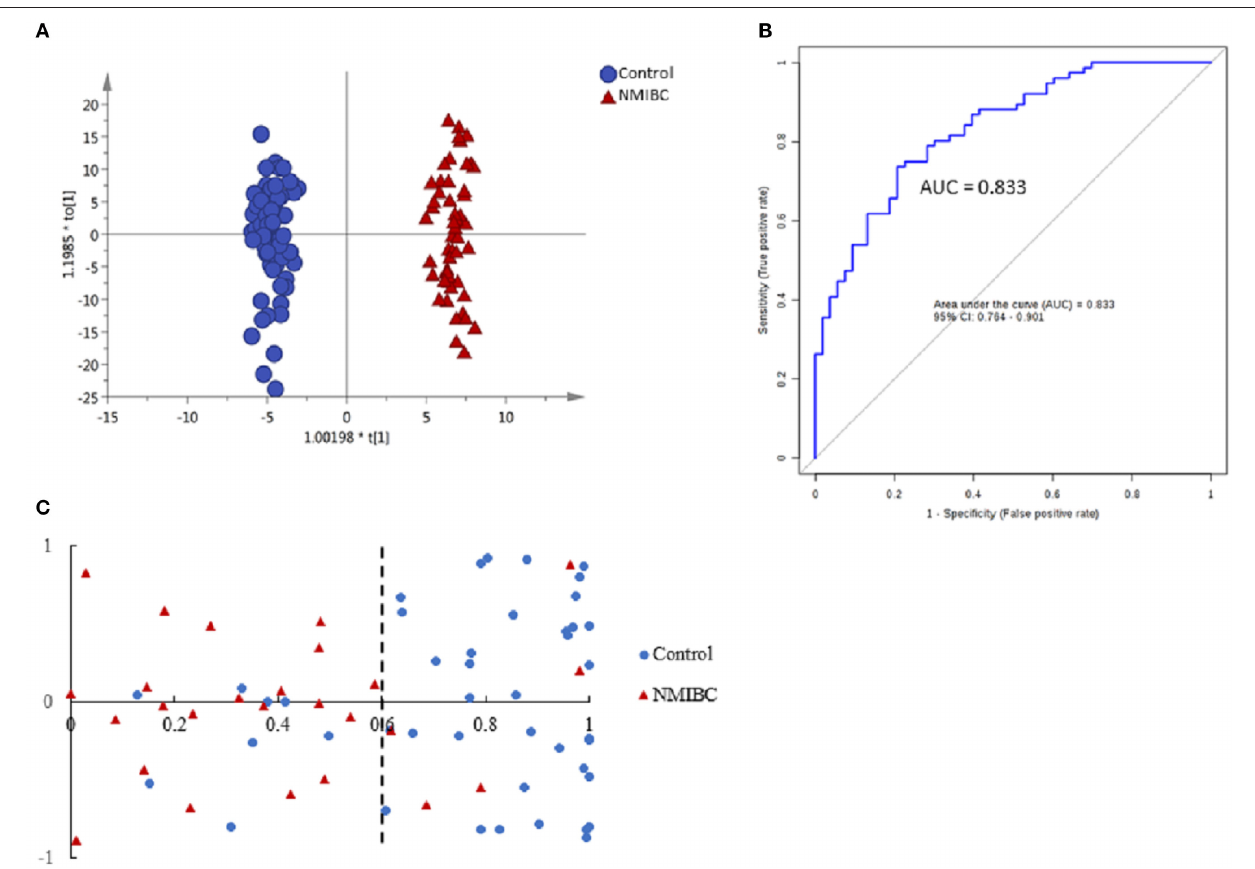
FIGURE 2 | Analysis of metabolic profiling in NMIBC as compared with control group. (A) Score plot of OPLS-DA model based on metabolome between NMIBC and control group. (B) ROC plot based on model to quantify the discrimination degree of NMIBC and control group. (C) External prediction accuracy of NMIBC prediction model established by a metabolite panel of Dopamine 4-sulfate, MG00/1846Z,9Z,12Z,15Z/00, Aspartyl-Histidine,